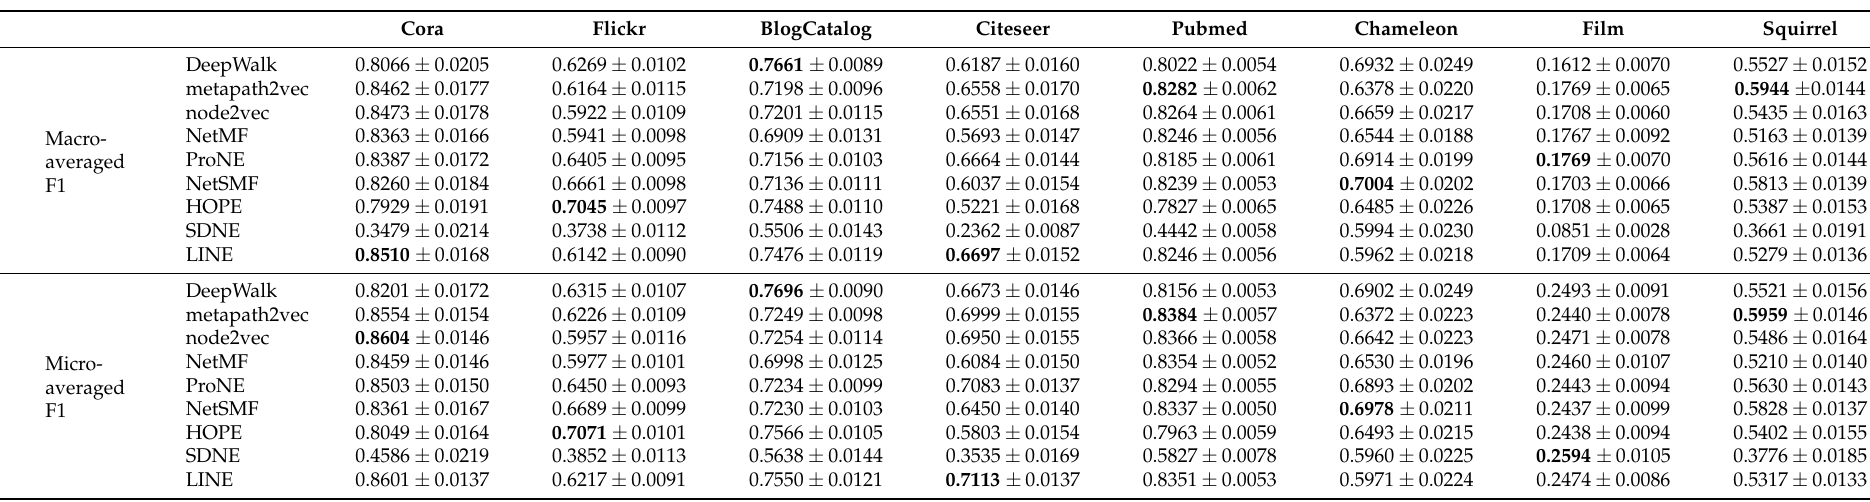
Table 3. Results in Task 1, i.e., classification fine tuned via validation set, on pure networks, using random search to tune hyperparameters. Best results are shown in bold.